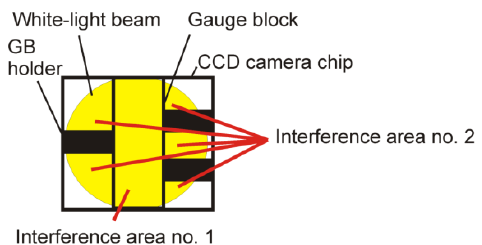
Figure 2. Sketch of the screenshot recorded by the CCD